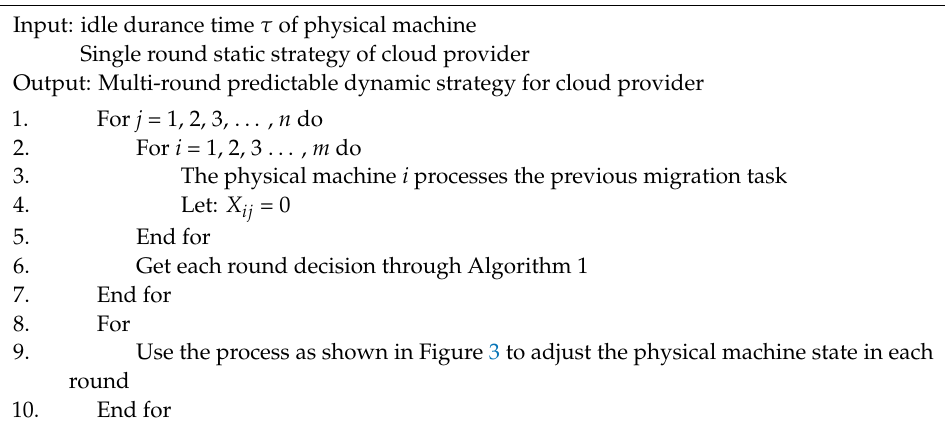
Figure 3. Flow chart of multi-round of physical machine state. Algorithm 2 Multi-round predictable dynamic strategy